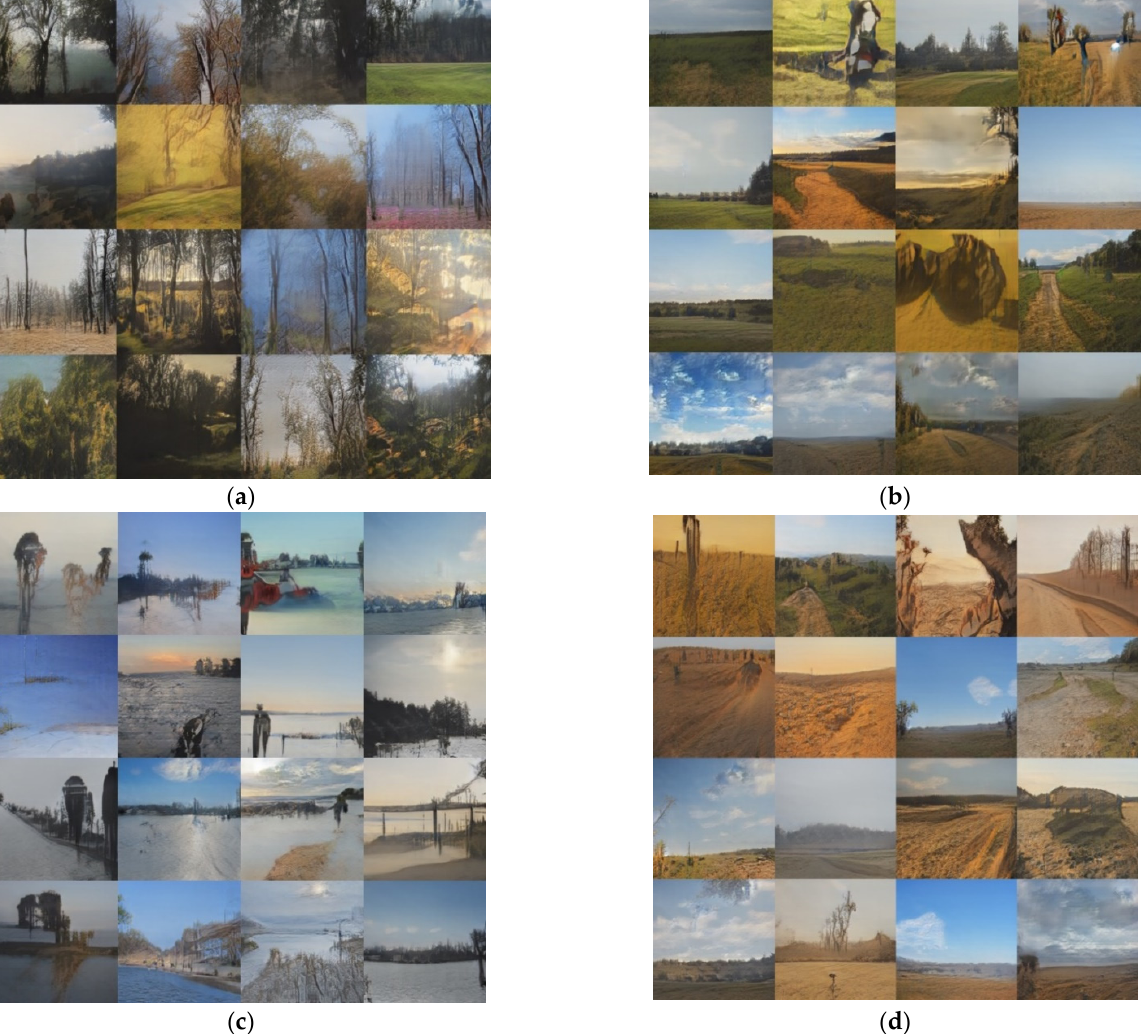
Figure 5. Images Generated by Different Description Combinations Using the Proposed Method. ( a ) “forest in the morning”, ( b ) “hayfield in autumn morning”, ( c ) “beach in winter morning”, ( d ) “sand in autumn”.